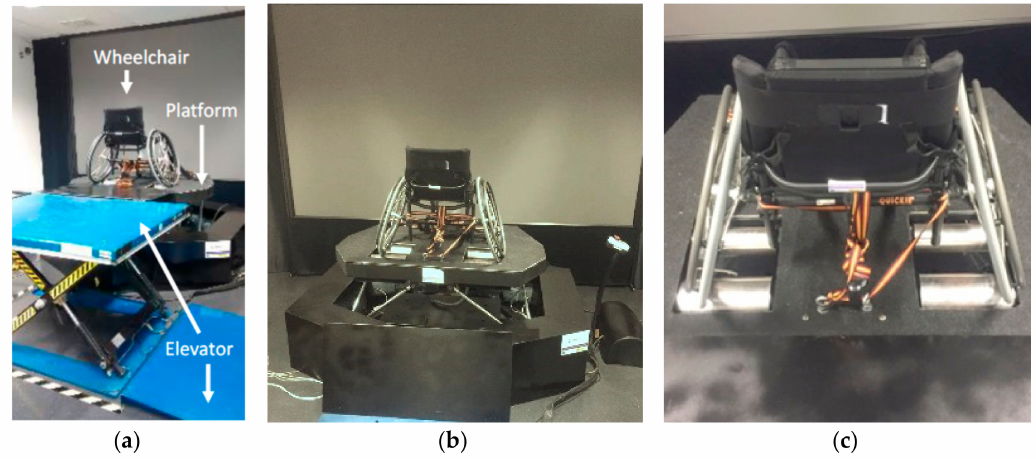
Figure 6. Physical systems: ( a ) component elements; ( b ) 6 DOF motion platforms and the wheelchair placed on it; ( c ) active